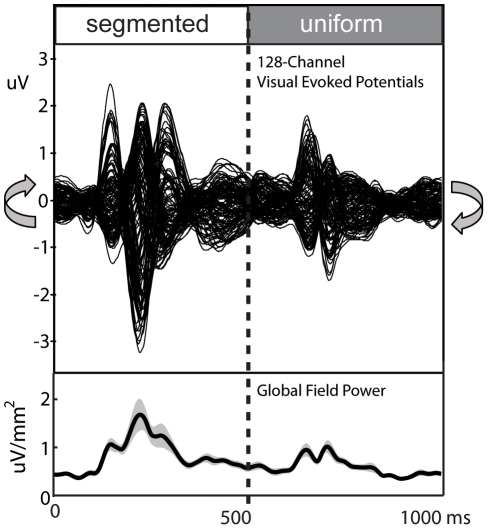
Grand average waveforms and global field power for the orientation-defined form response.Prominent responses are present to the both the appearance (left) and disappearance (right) of the orientation-defined figure. Responses are larger and more protracted following the onset of the figure region than the return to a uniform state. Curved arrows to the left and right of the waveforms indicate that this is the response to a periodic stimulus. The grey shading around the Global Field Power trace indicates +/−1 standard error of measurement for the mean GFP.